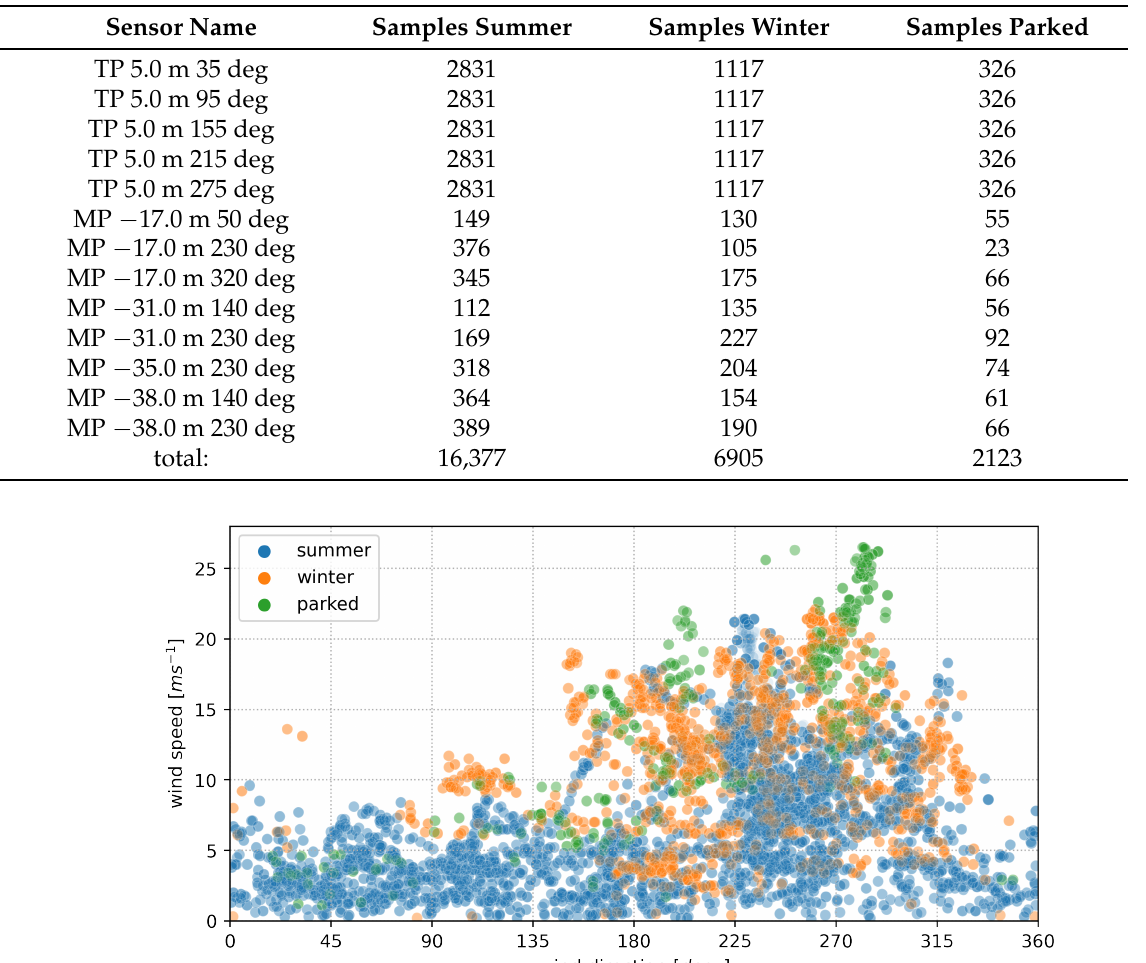
Table 1. Number of samples in each validation set per sensor location.